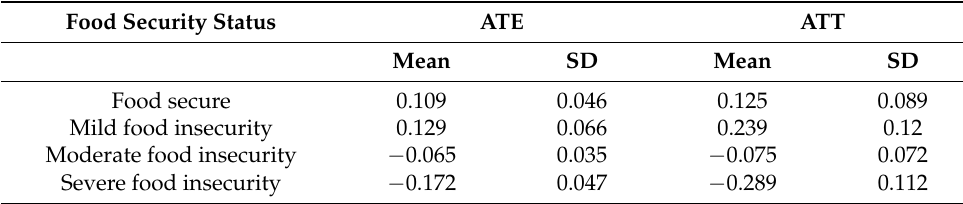
Table 4. ATE and ATT of adaptation strategies on the severity of food insecurity. Food Security Status